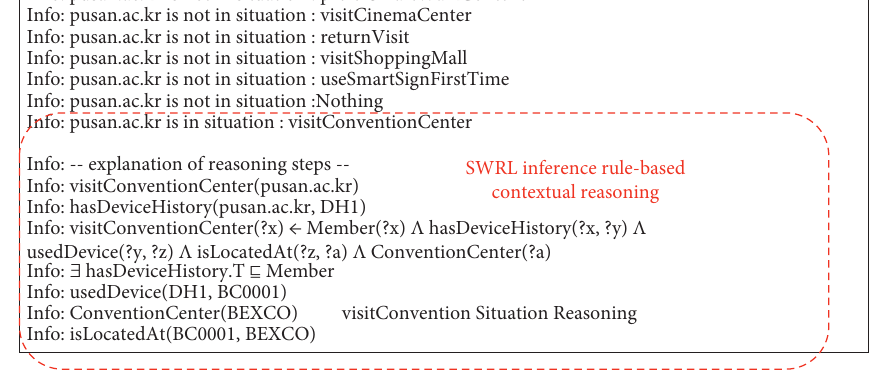
Figure 8: Inference results.